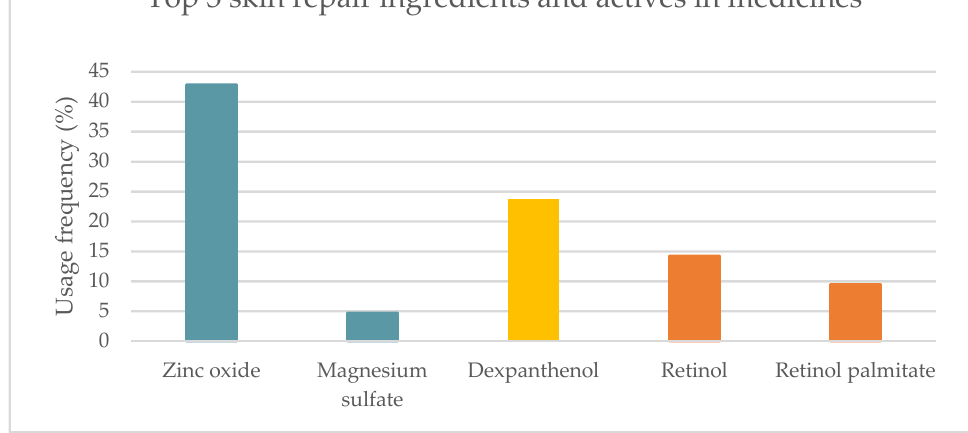
Figure 5. Usage frequency of the top 3 wound repair ingredients and actives in medicines extended: metal salts and oxides (blue), vitamin B5 derivative (yellow), vitamin A and derivative (orange).